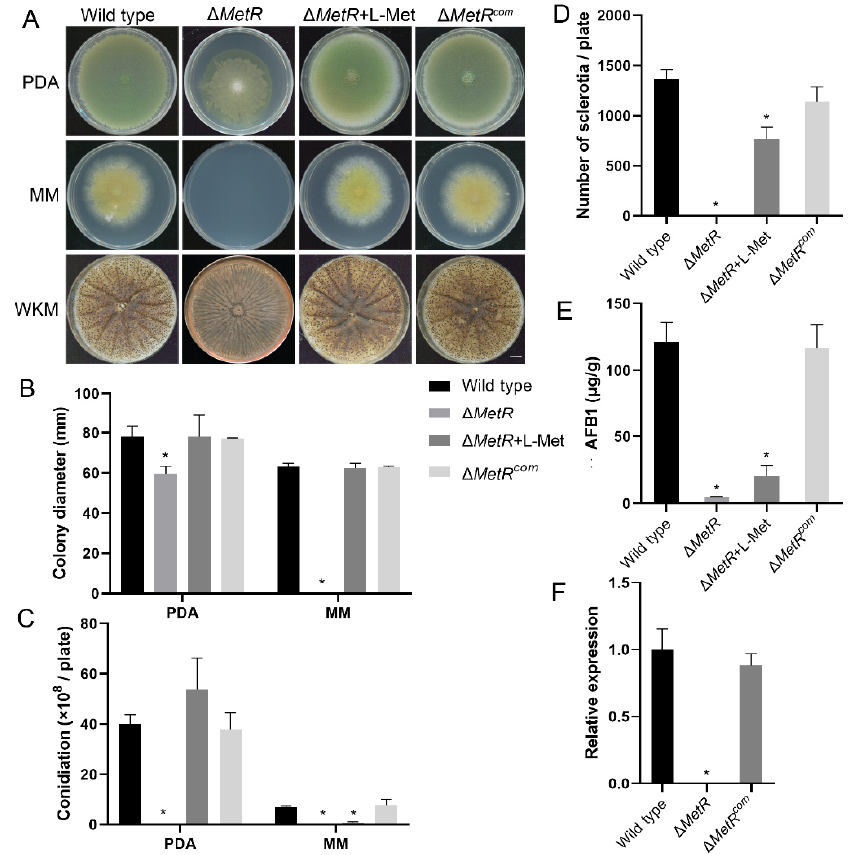
Figure 12. Phenotypic analysis of the ∆ MetR and ∆ MetR com strains. ( A ) Colonies of the wild-type strain, ∆ MetR mutant and complemented strain ( ∆ MetR com ) on different media. Each strain was inoculated on PDA and MM for 7 days at 30 ◦ C and on WKM medium for 10 days at 30 ◦ C in dark. In addition, ∆ MetR was inoculated on three other types of media supplemented with 5 mM L-methionine (L-Met). Bar = 1 cm. ( B ) Colony diameter of each strain. ( C ) Conidial production of each strain. ( D ) Sclerotial production of each strain. Bar = 5 mm. ( E ) Aflatoxin B1 production measured per µ g/g of mycelia. ( F ) A relative expression assay of the MetR gene in ∆ MetR com using quantitative PCR. Error bars represent the SD. * p < 0.05, significant difference from the wild-type group estimated by a Dunnett test. MM, minimal media; PDA, potato dextrose agar; SD, standard deviation; WKM, Wickerham